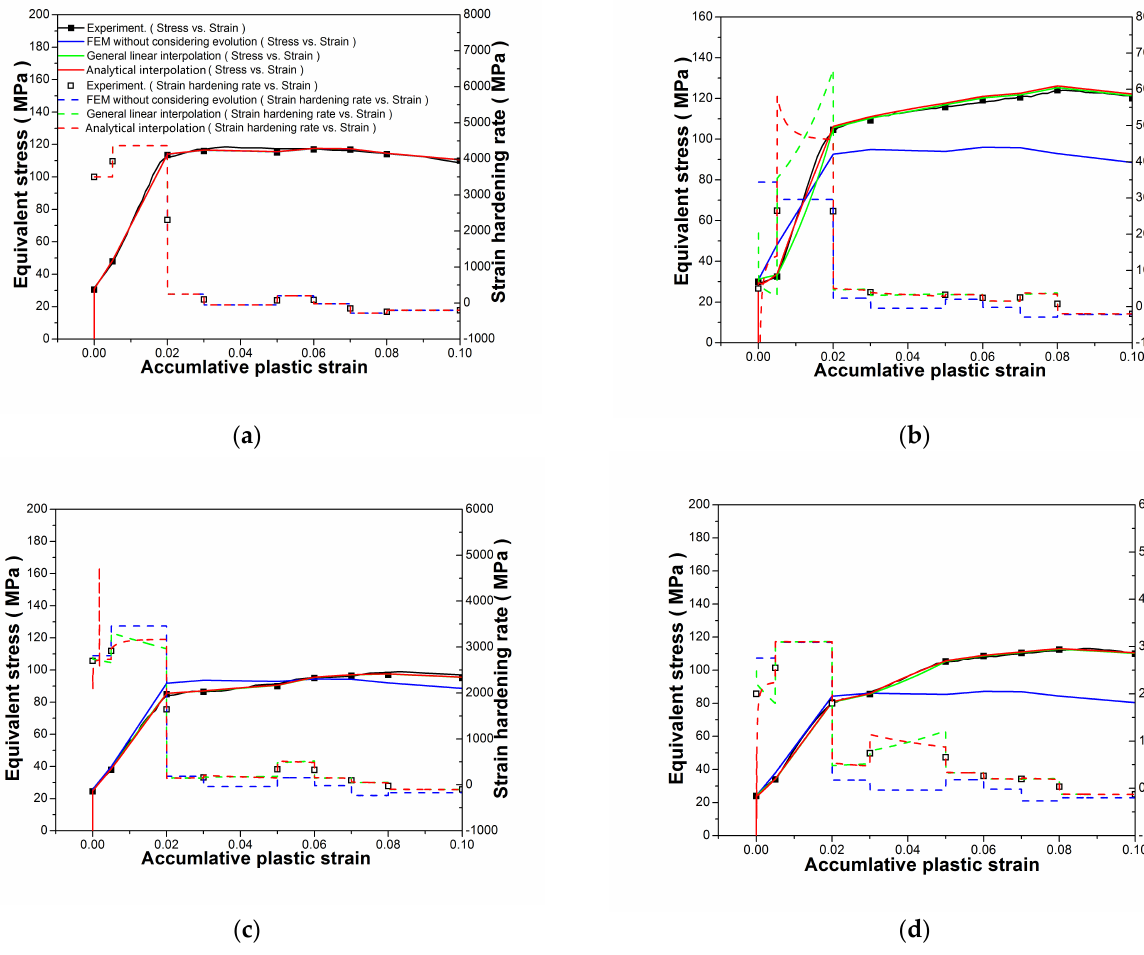
Figure 6. Stress-strain relationships and strain hardening rates of continuous deformation uniaxial loading of ZK60 magnesium alloy: ( a ) X uniaxial tension; ( b ) X uniaxial compression; ( c ) Y uniaxial tension; and ( d ) Y uniaxial compression.